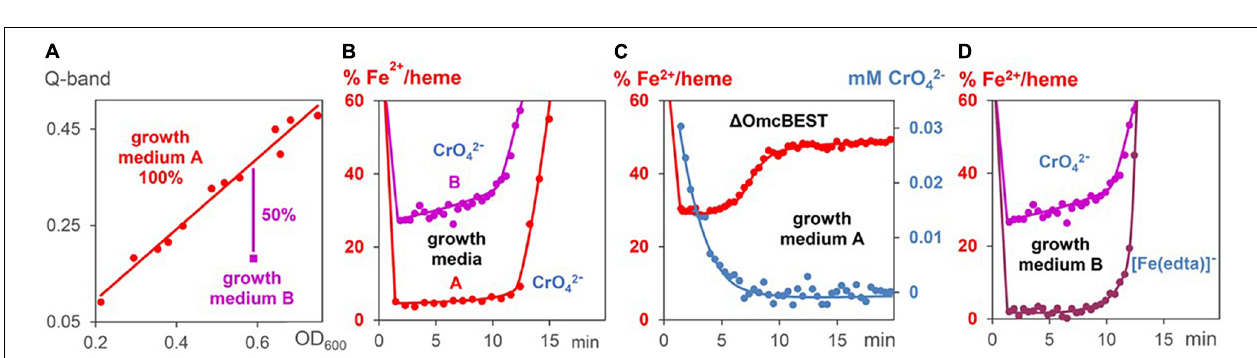
FIGURE 5 | Changes of Fe 2 + /heme levels during metal induced respiration of G. sulfurreducens . (A) Linear correlation (red line) between Fe 2 + /heme concentrations (Q-bands) and G. sulfurreducens concentrations (OD 600 data). The data (red points) were gained by dilution and different cell growth experiments in medium A. Measurement (magenta point) with G. sulfurreducens , grown in medium B, where c -cytochromes are downregulated. (B) Fe 2 + /heme levels during CrO 42 − induced respiration (0.05 mM) of cells grown in media A (0.63 pM) and B (0.73 pM). (C) Fe 2 + /heme levels (red) and CrO 42 − concentrations (blue) during CrO 42 − induced respiration (0.05 mM) of mutants lacking OmcBEST (0.76 pM) grown in medium A. (D) Fe 2 + /heme levels of experiments with G. sulfurreducens (0.74 pM), grown in medium B, with [Fe(edta)] − (0.15 mM) and CrO 42 − (0.05 mM),